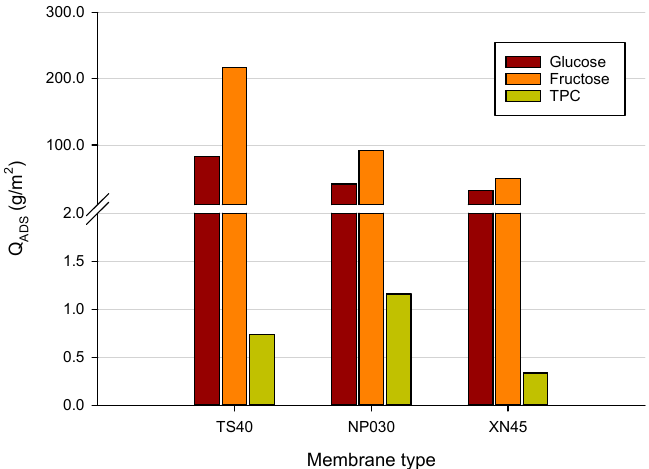
Figure 7. Amount of adsorbed glucose, fructose, and TPC for selected membranes.